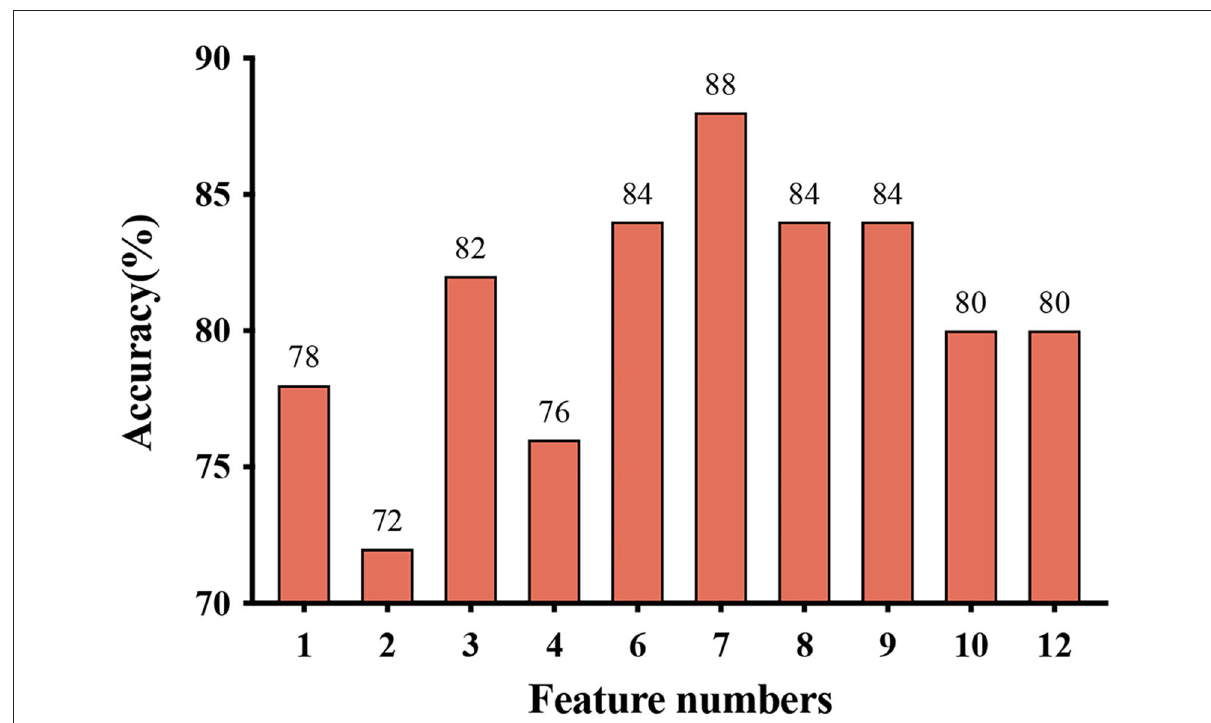
FIGURE2 Feature numbers and classification accuracy for each classifier when using feature